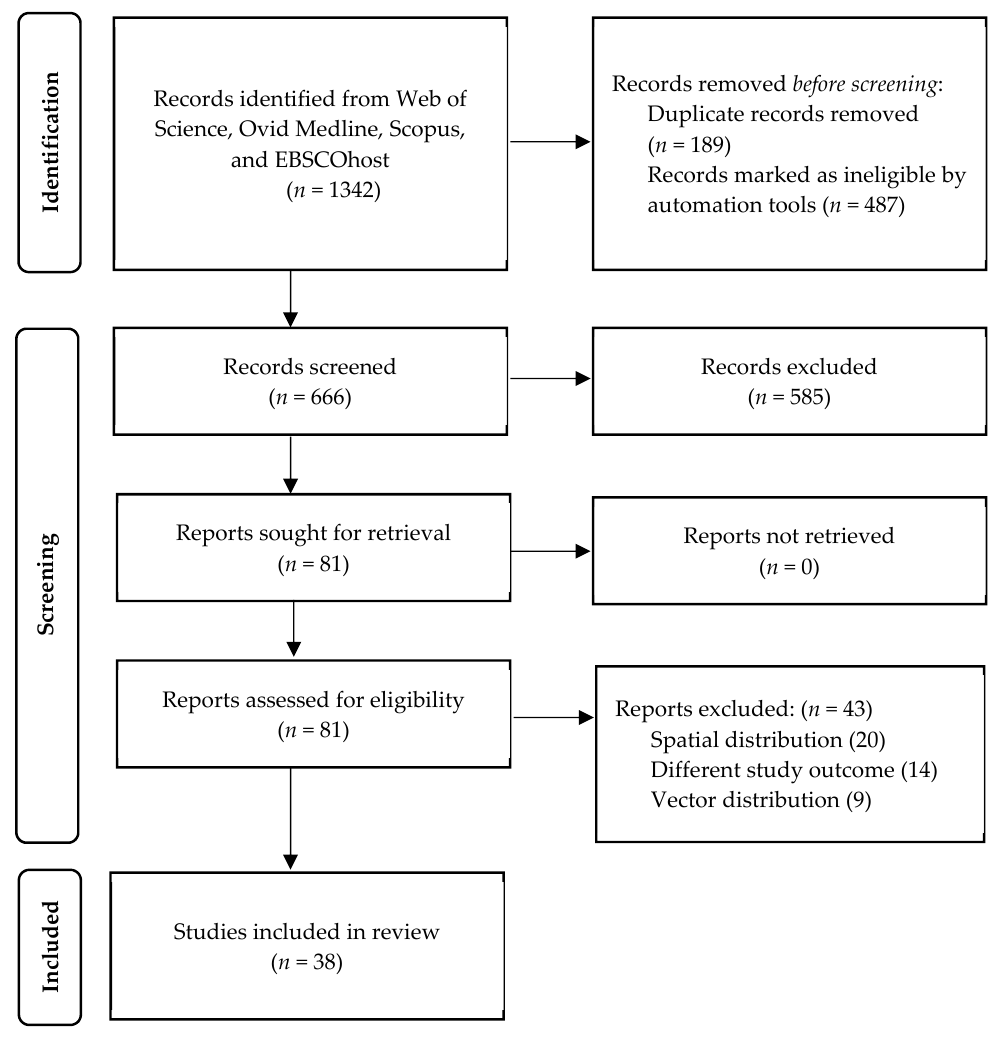
Figure 1. PRISMA flow diagram.